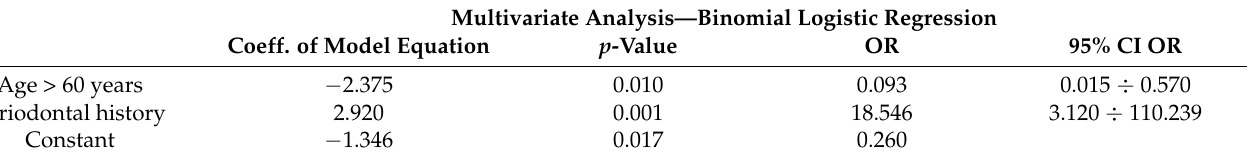
Table 8. Multivariate analysis regarding significant risk factors of prosthetic success for tooth- supported